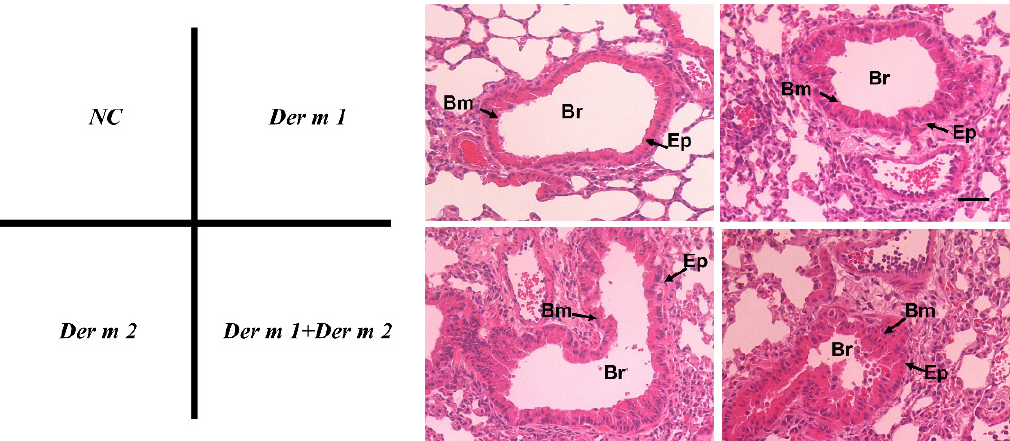
Figure 6. The more severe airway inflammation in Der m 1 + Der m 2 -sensitized mice. Lung tissue sam- ples were obtained for histopathological analysis of airway inflammation for the NC group, Der m 1 sensitized/challenged mice, Der m 2 sensitized/challenged mice, and a group of Der m 1 + Der m 2 sensitization mice, respectively. All lung tissue was stained with hematoxylin and eosin to evaluate the inflammation severity and goblet-cell hyperplasia. Br = bronchus, Bm = basement membrane, Ep = epithelium.